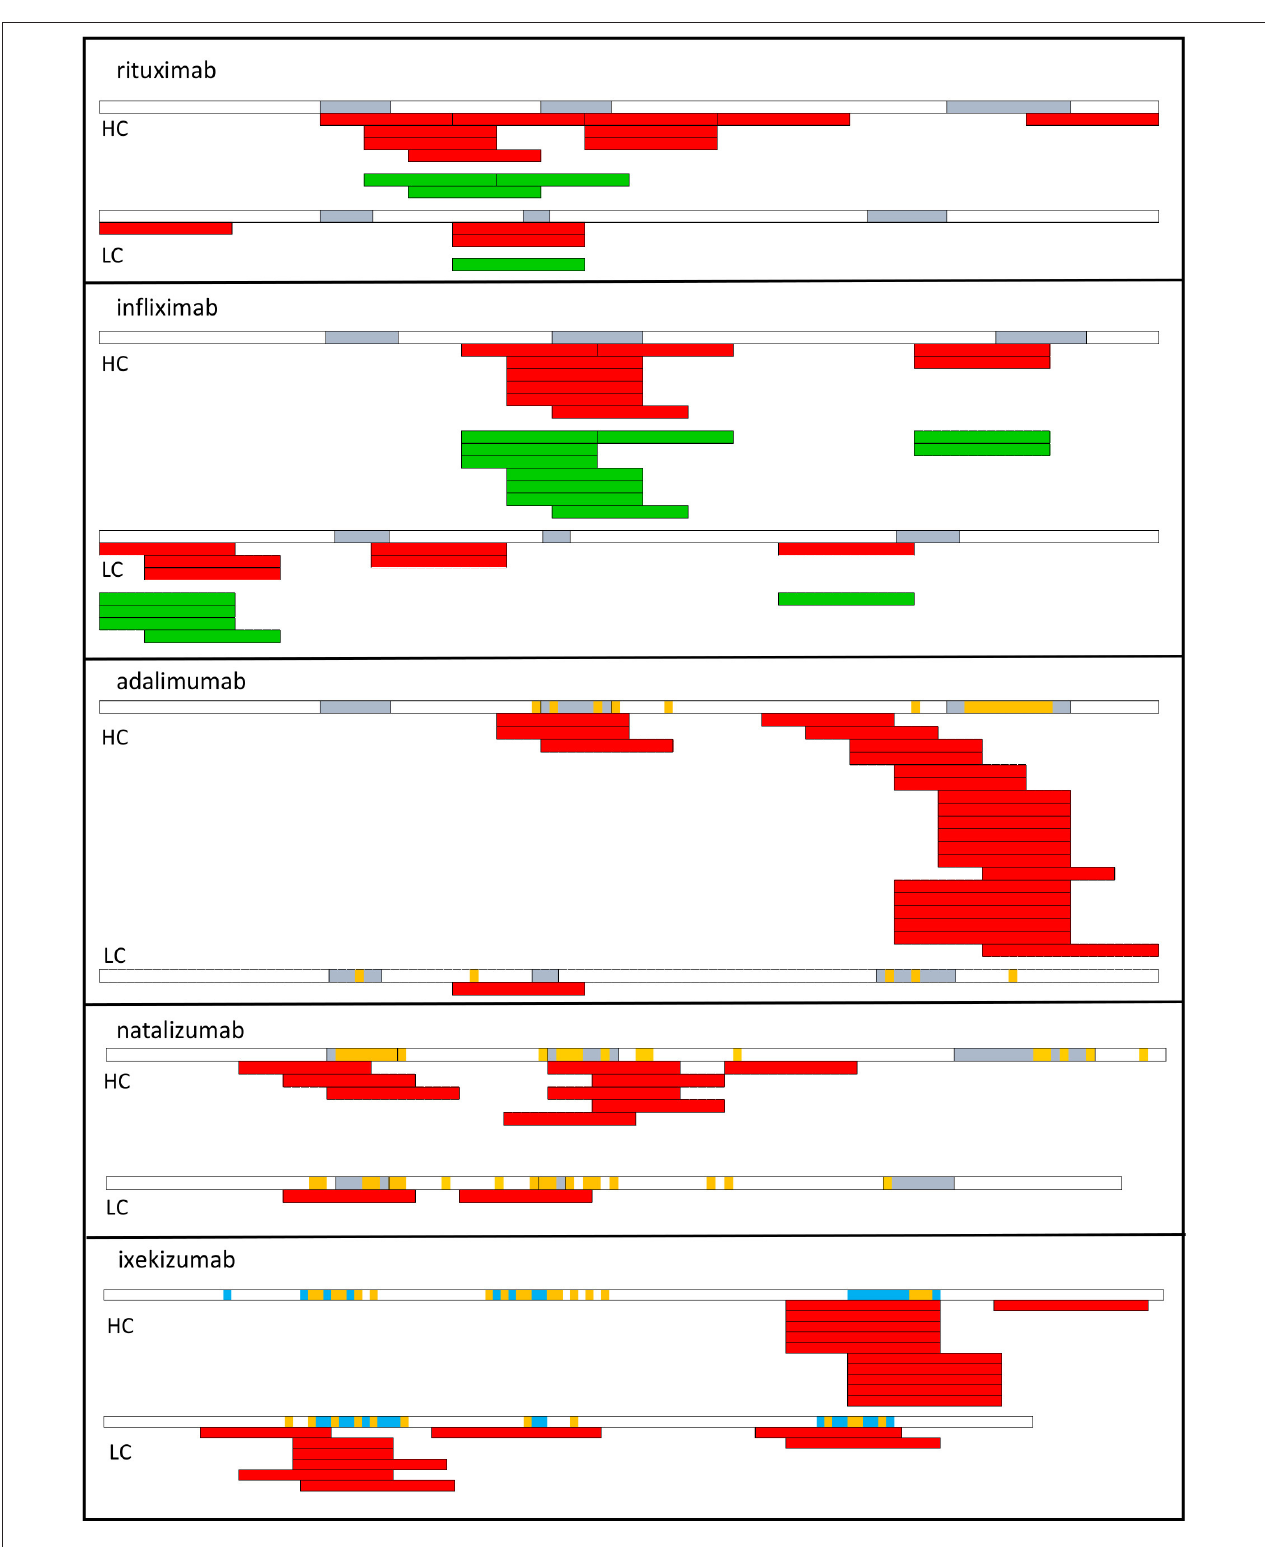
FIGURE 2 | T cell epitopes of therapeutic antibodies. T cell epitopes have been identified from T cells collected from healthy donors (red) or from patients who develop an ADA response (green) to rituximab, infliximab (53), adalimumab, natalizumab (72), and ixekizumab (73). Each bar corresponds to an individual response. CDR regions are shown in blue. Amino acids in orange correspond to mutations with respect to the best-fitting germline sequence. HC, heavy chain; LC, light chain.